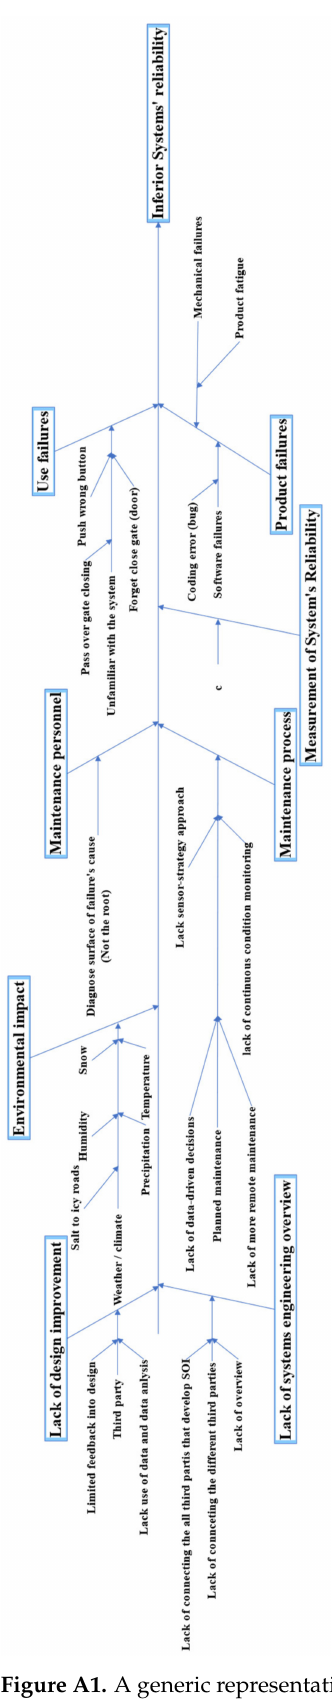
Figure A1. A generic representation of the cause and effect of the failure events using an Ishikawa diagram, which is also known as a fishbone